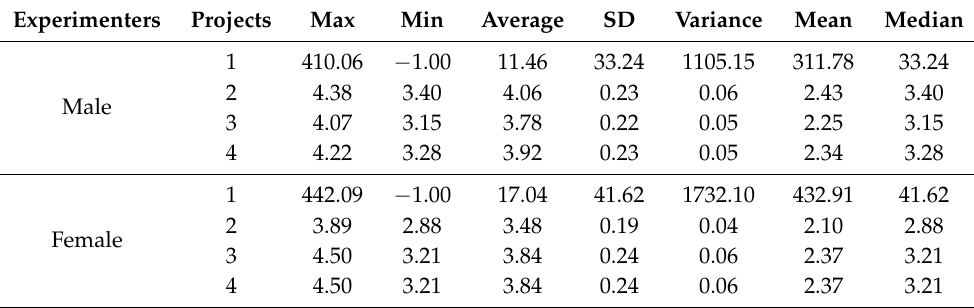
Table 3. Validation interface 2: Frequency domain analysis of male subjects’ eye movement data. Note: 1: eye-velocity processing data, 2: left-pupil processing data, 3: right-pupil processing data, 4: mean-pupil processing data.